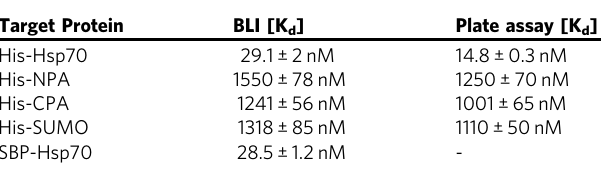
Table 5 The binding af fi nity of HSc-9.1 against different